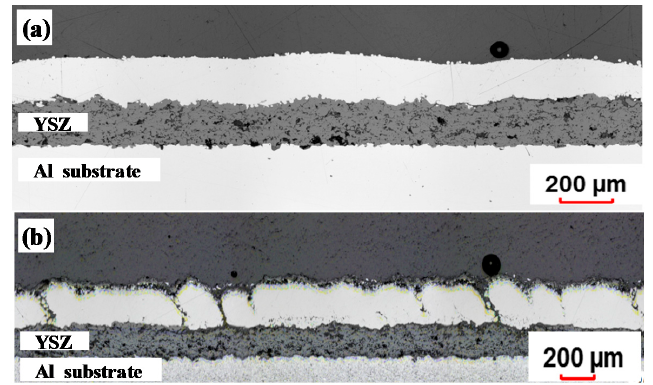
Figure 7. Cross sectional micrographs for optimized tracks: ( a ) chromel; ( b ) alumel. Table 2. Experimental and nominal resistivity of type K thermocouple.